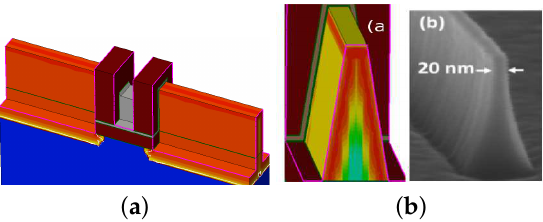
Figure 1. Proposed device ( a ) architecture and ( b ) aliment of the fin as per the experimental data [20].